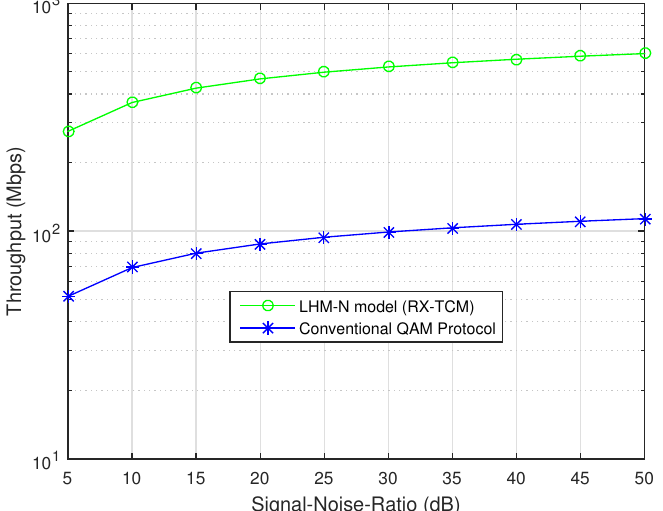
Figure 7. Comparative analysis of the throughput for LHM-N and the conventional QAM